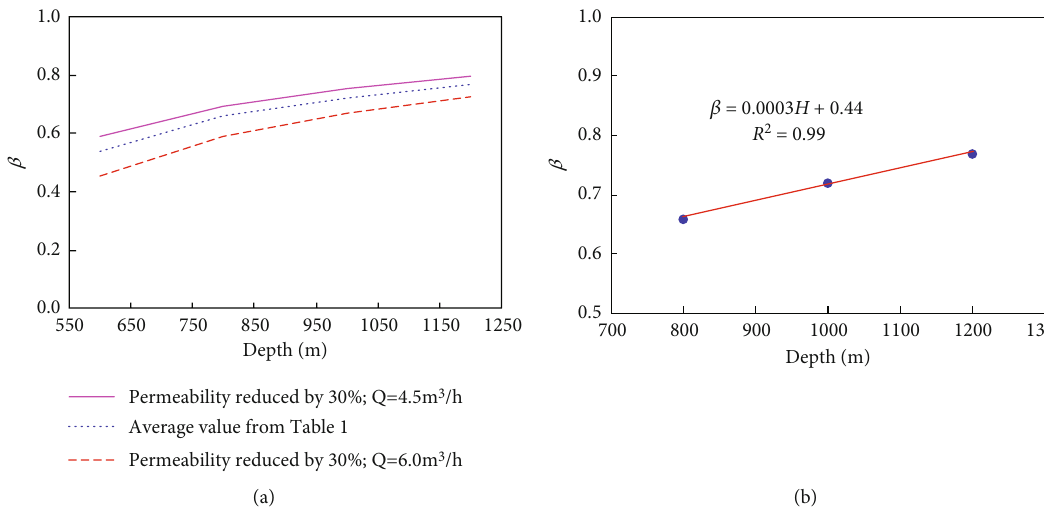
Figure 8: Suggested value of water pressure reduction coe ffi cient of shaft lining: (a) evolution of β ; (b) suggested equation.